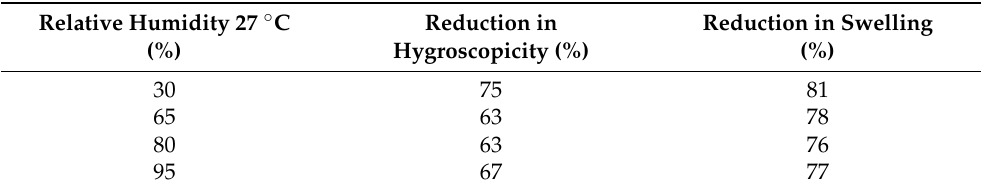
Table 2. Percent reduction in hygroscopicity and antishrink efficiencies (ASE) in acetylated (30% acetyl content) Sitka spruce between oven-dry and various relative humidifies [7]. Relative Humidity 27 ◦ C